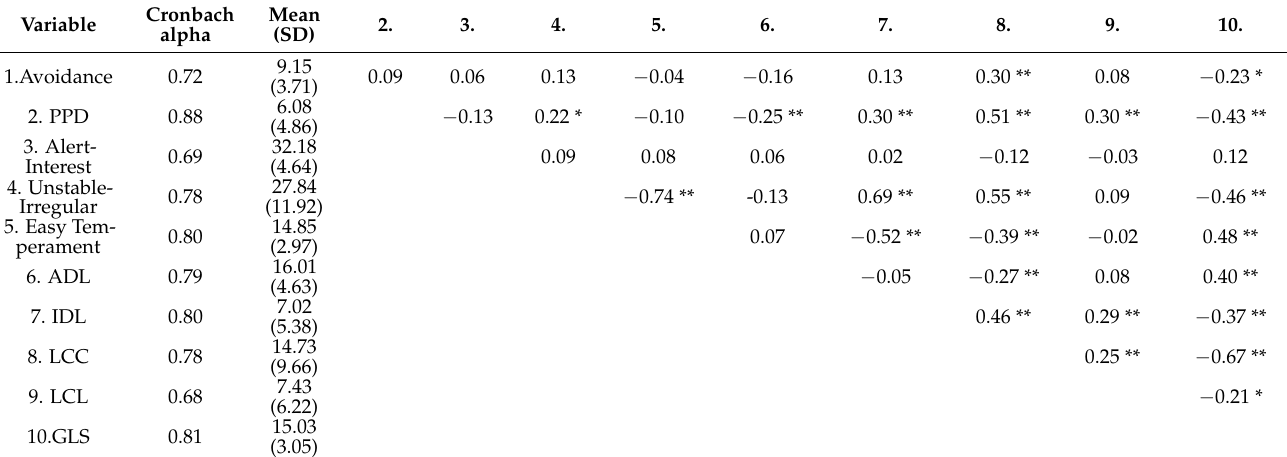
Table 1. Means, standard deviations, and Pearson correlations between study